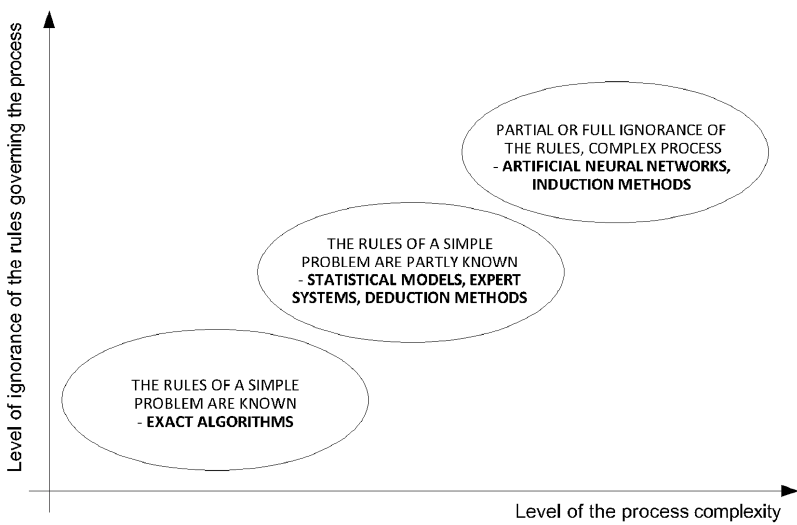
Figure 5. Features of the problems where applying ANN brings more accurate results in solving the problem